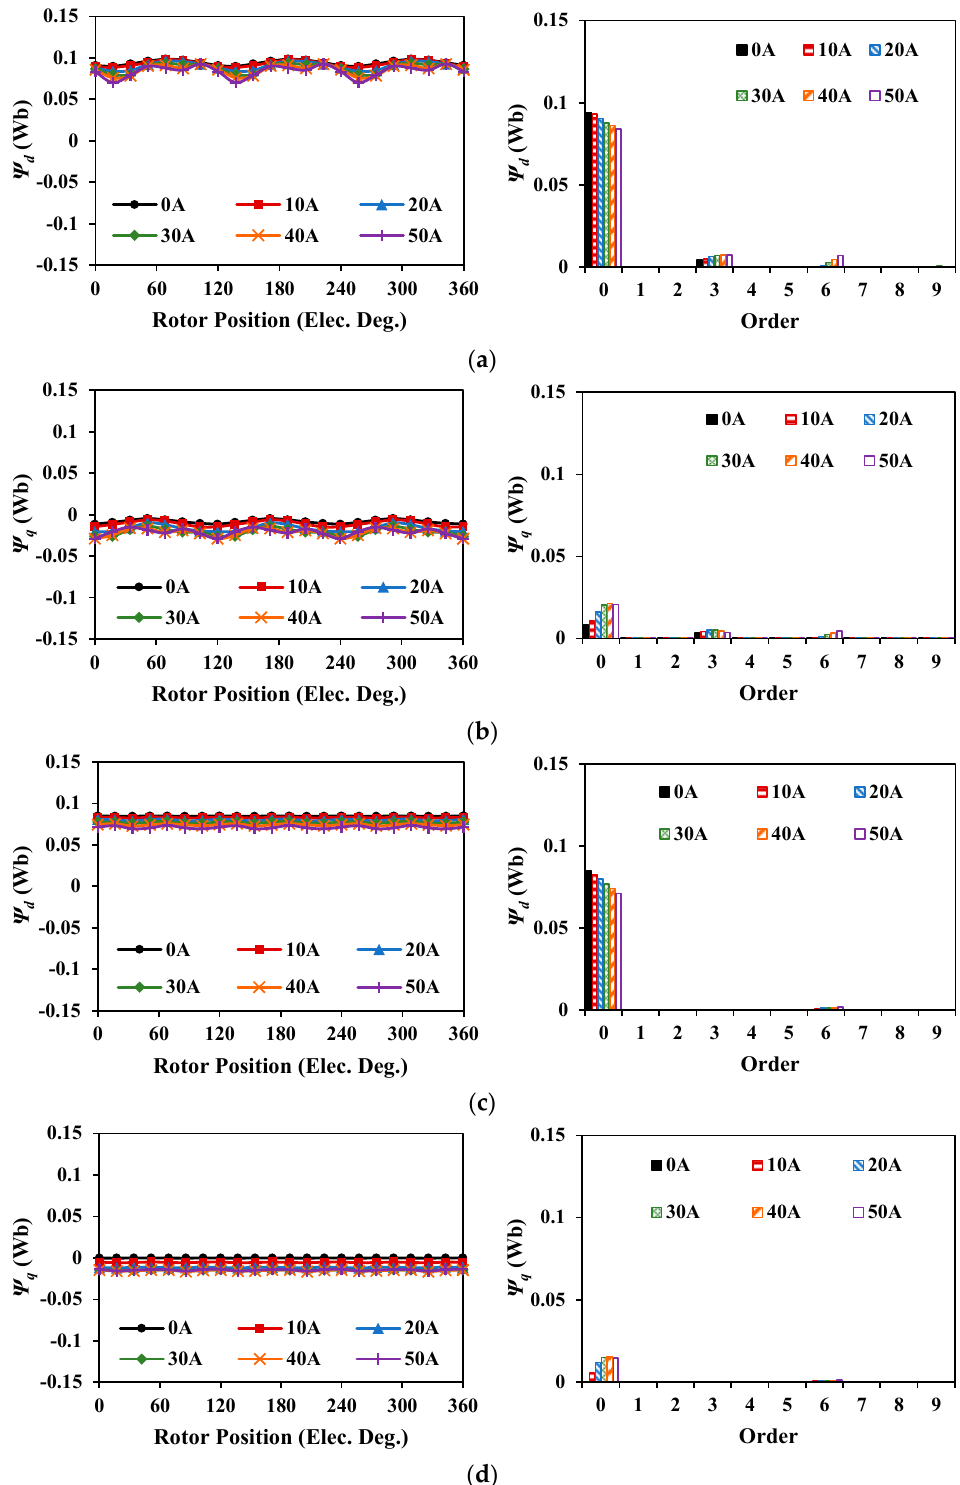
Figure 29. Flux linkages and spectra of two PSCPPM machines. ( a ) D-axis flux linkage of 12s8p- PSCPPM. ( b ) Q-axis flux linkage of 12s8p-PSCPPM. ( c ) D-axis flux linkage of 12s10p-PSCPPM. ( d ) Q-axis flux linkage of 12s10p-PSCPPM.